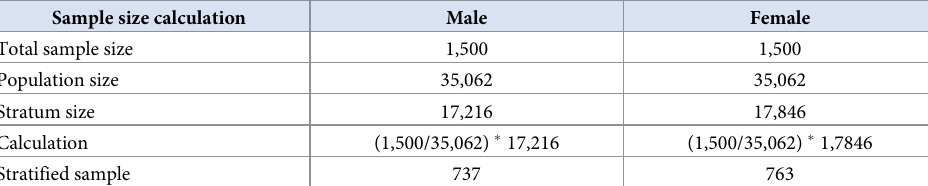
Table 1. Sample size